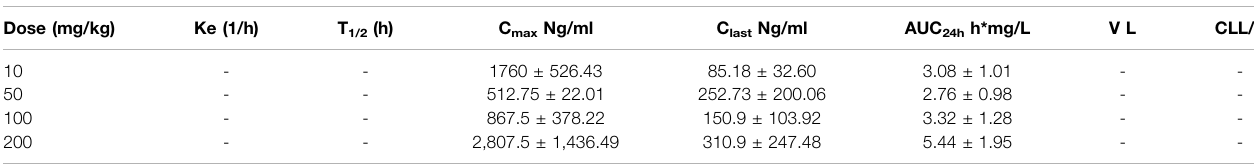
TABLE 4 | Pharmacokinetic values of 25 – 106 in the liver.